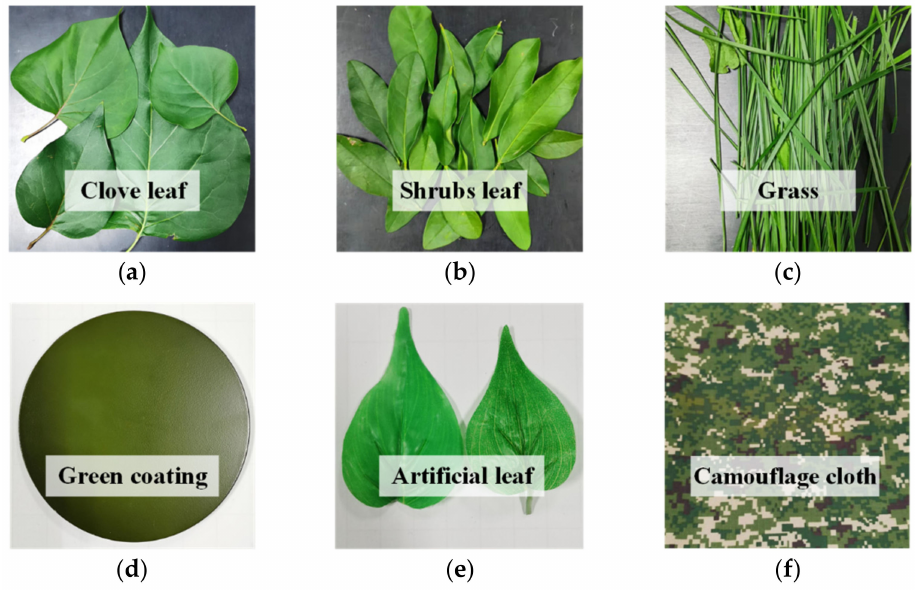
Figure 4. ( a ) Clove leaf; ( b ) shrub leaf; ( c ) grass; ( d ) green coating; ( e ) artificial leaf; ( f ) camouflage